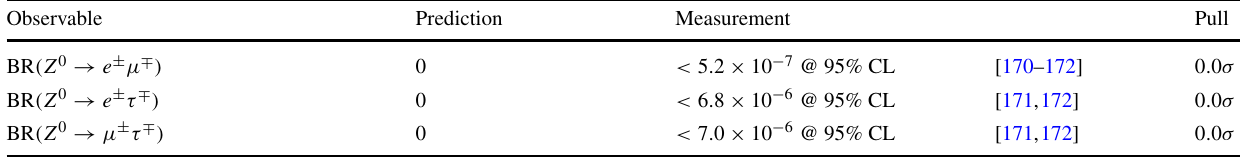
Table 12 Z decay LFV